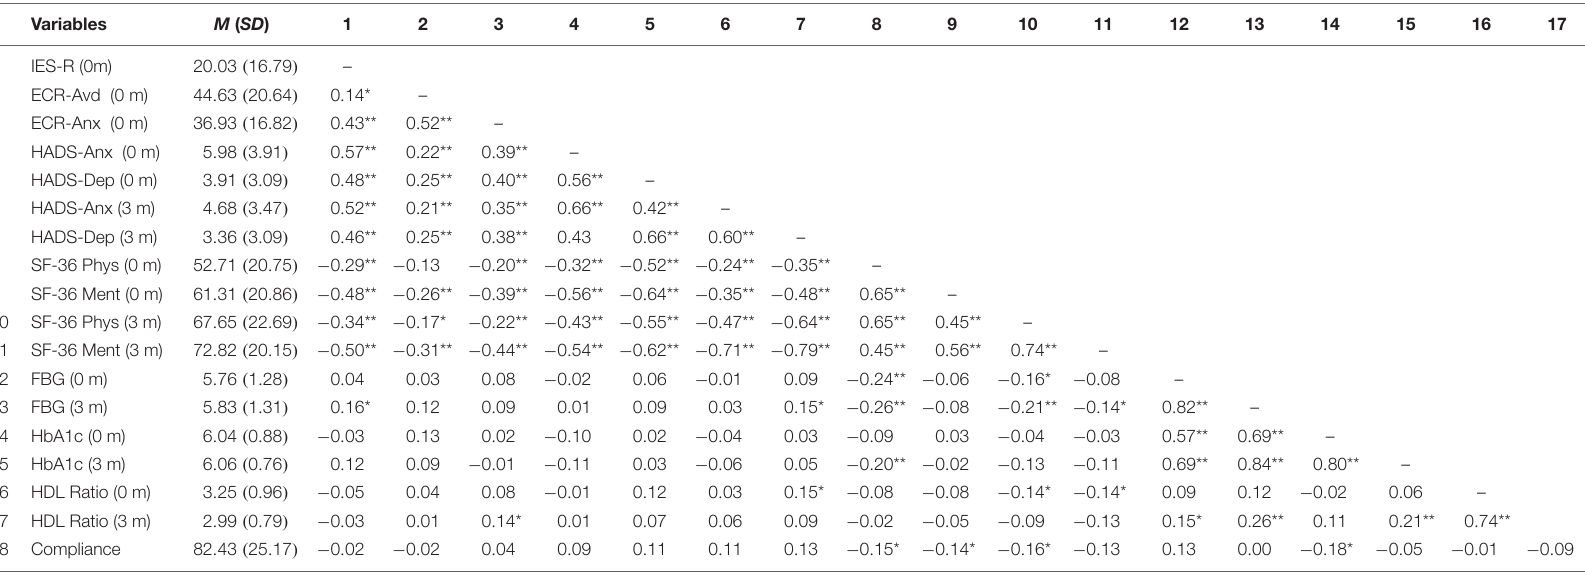
TABLE 2 | Means, standard deviations, and correlations for all study